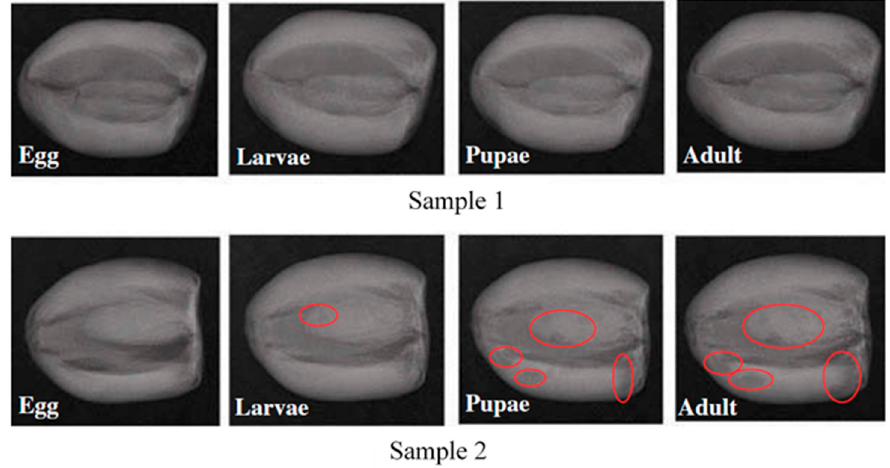
Figure 5. X-ray images of two samples of dates infested with Oryzaephilus surinamensis at different life stages. Samples 1 show infestation that is not visually recognizable, and samples 2 show identifiable infestation in areas circled in red [76] .